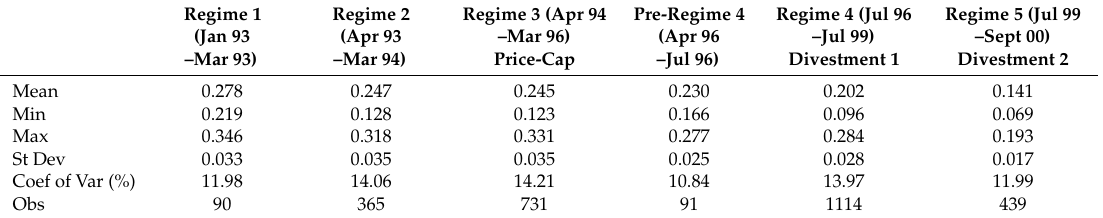
Table 3. Summary statistics for PG’s market share during the peak-demand period over trading